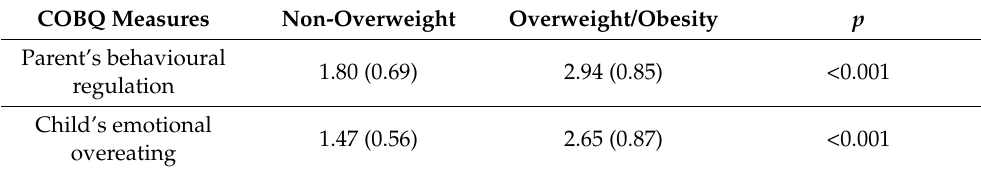
Table 2. Measures for the two scales of the Childhood Obesogenic Behaviours’ Questionnaire by BMI